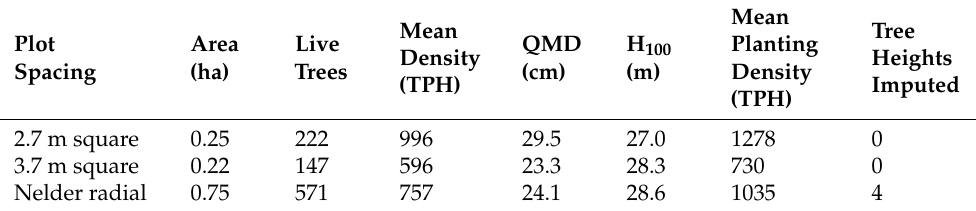
Table 3. Summary of the three Douglas-fir spacing trial plots used for growth model initialization, as measured at age 30. All three plots are located in the Malcolm Knapp Research Forest in